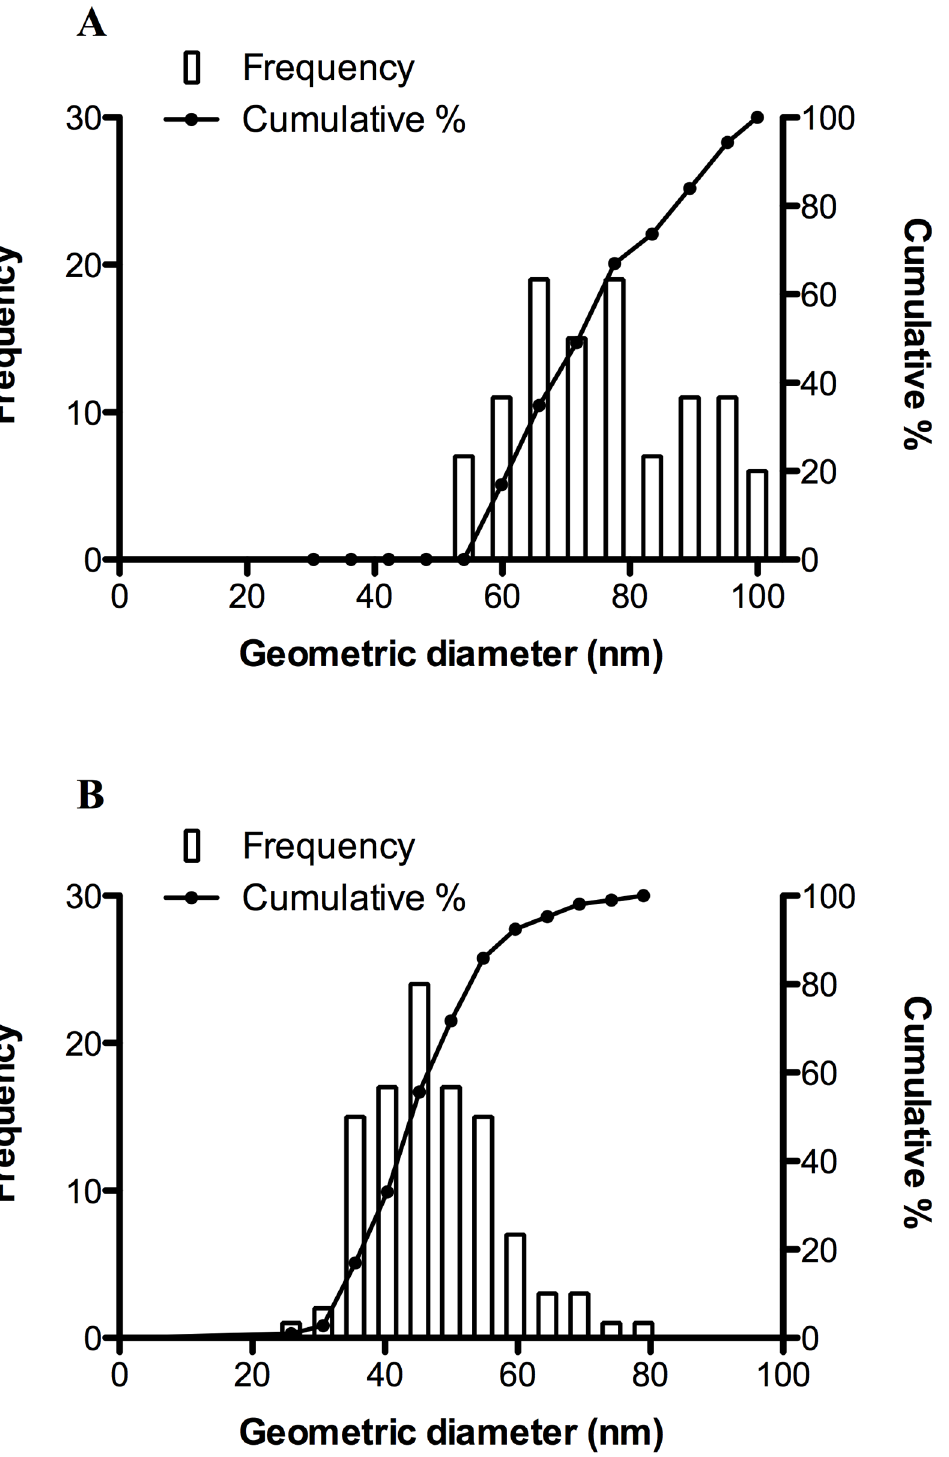
Fig 1. Particle size distribution by frequency percent of total particle volume and cumulative percentage of size classes. The individual graphs demonstrate the particles size of OAgNPs (A) and PAgNPs (B) counted using transmission electronic microscope (No. of particle counted = 106).